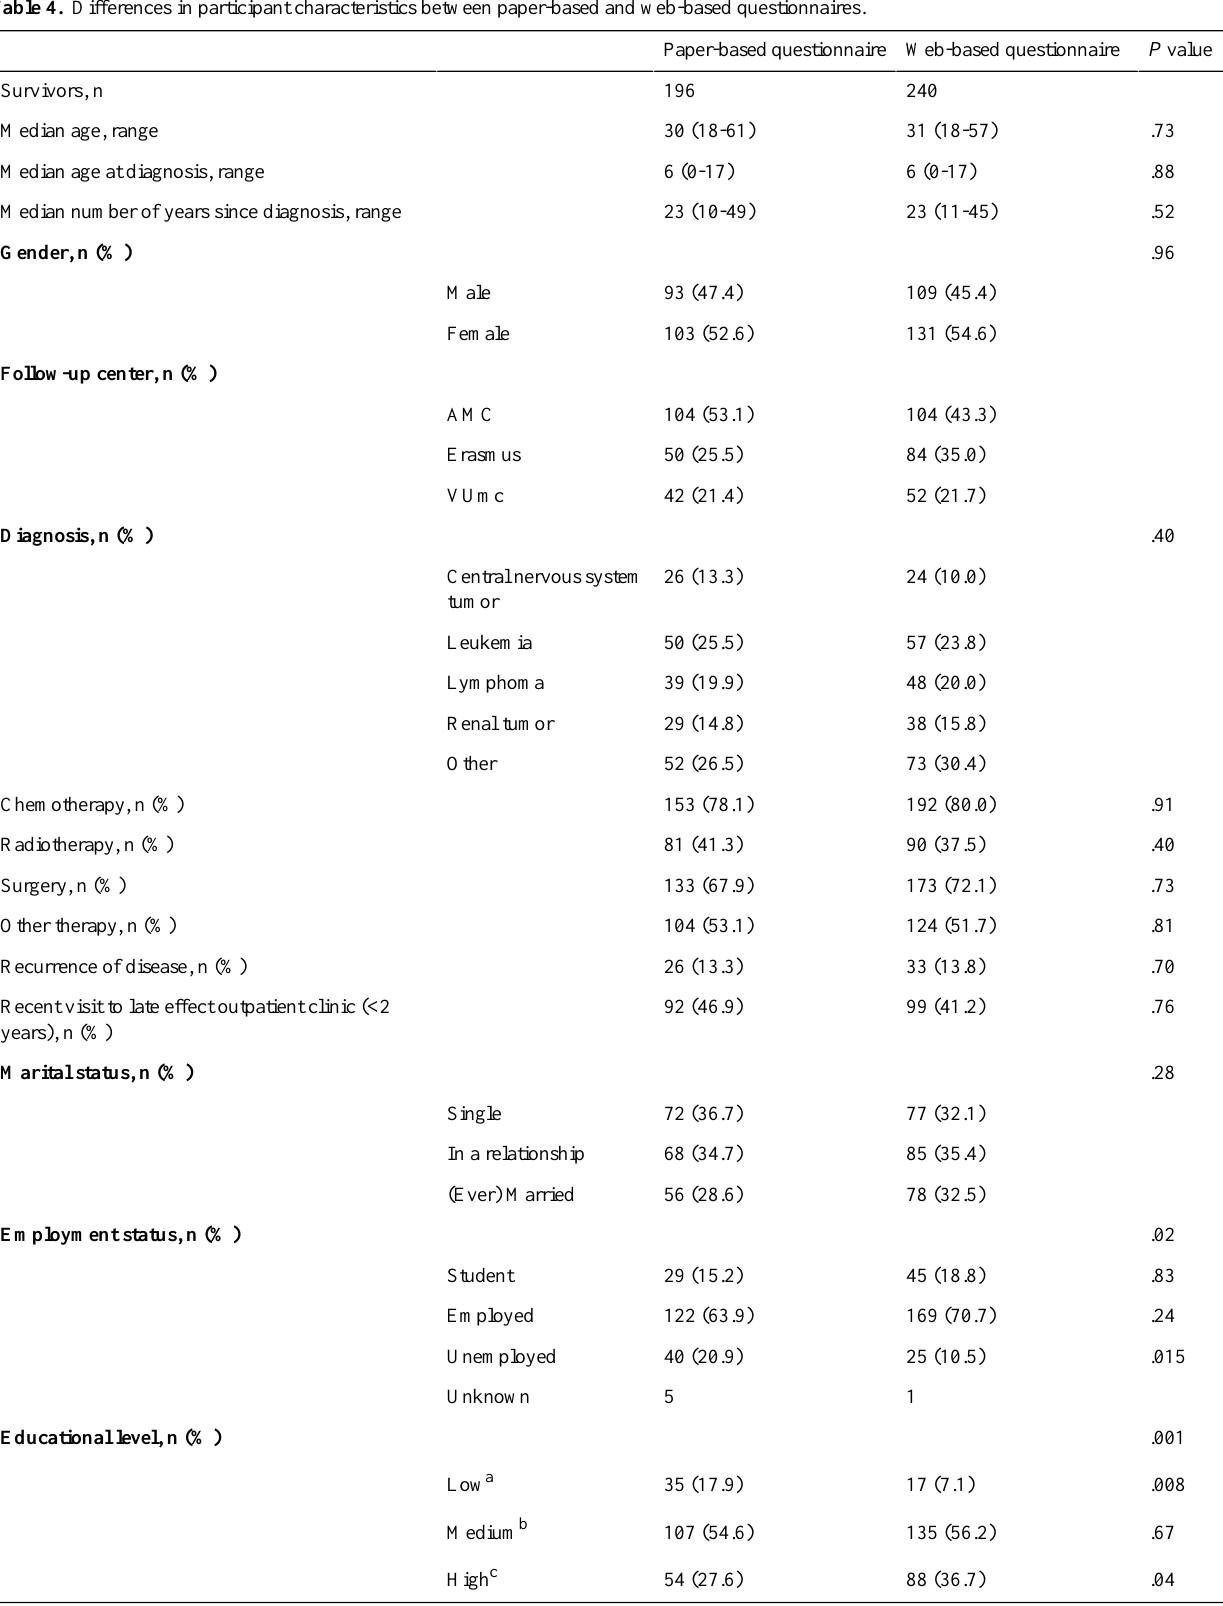
Table 4. Differences in participant characteristics between paper-based and web-based questionnaires.